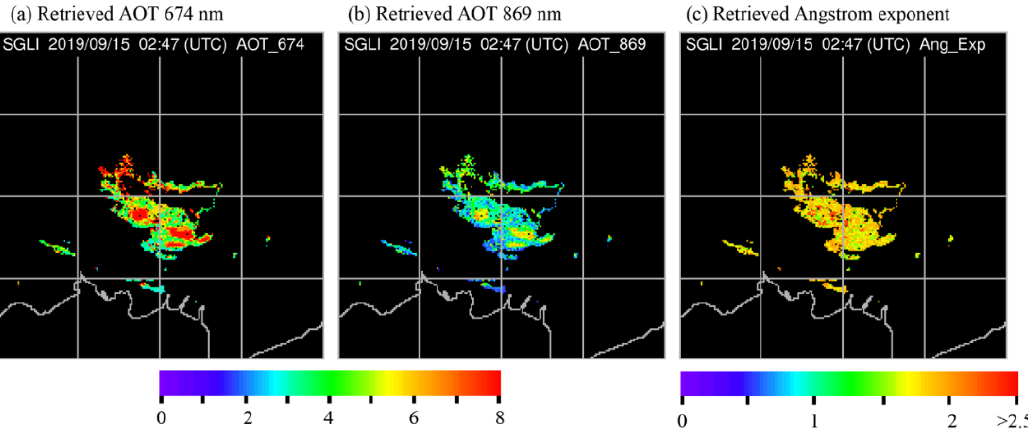
Figure 6. ( a , b ) Aerosol optical thickness (AOT) and ( c ) Ångström exponent (AE) retrieved from the second-generation global imager (SGLI) using the vector method of adding–doubling (VMAD) on 15 September 2019. A comparison of the measurements at the AERONET site, Palangkaraya, is shown in Figure 7. Each error bar represents the standard deviation of the retrieved 3 pixel × 3 pixel near the AERONET station. The obtained AOT values were consistent with the AERONET ground-based observations at both wavelengths. Currently, the maximum value that can be analyzed by AERONET is 7. However, the AOT values for wavelengths shorter than 600 nm are too large to be produced. Thus, the aerosol retrieval algorithm proposed in Section 4.2.1 is validated by the AERONET data. Nevertheless, further comparisons and verifications are necessary. The AE value of approximately 1.7 retrieved from the SGLI is consistent with the ground-based AERONET observation, indicating the presence of small particles.